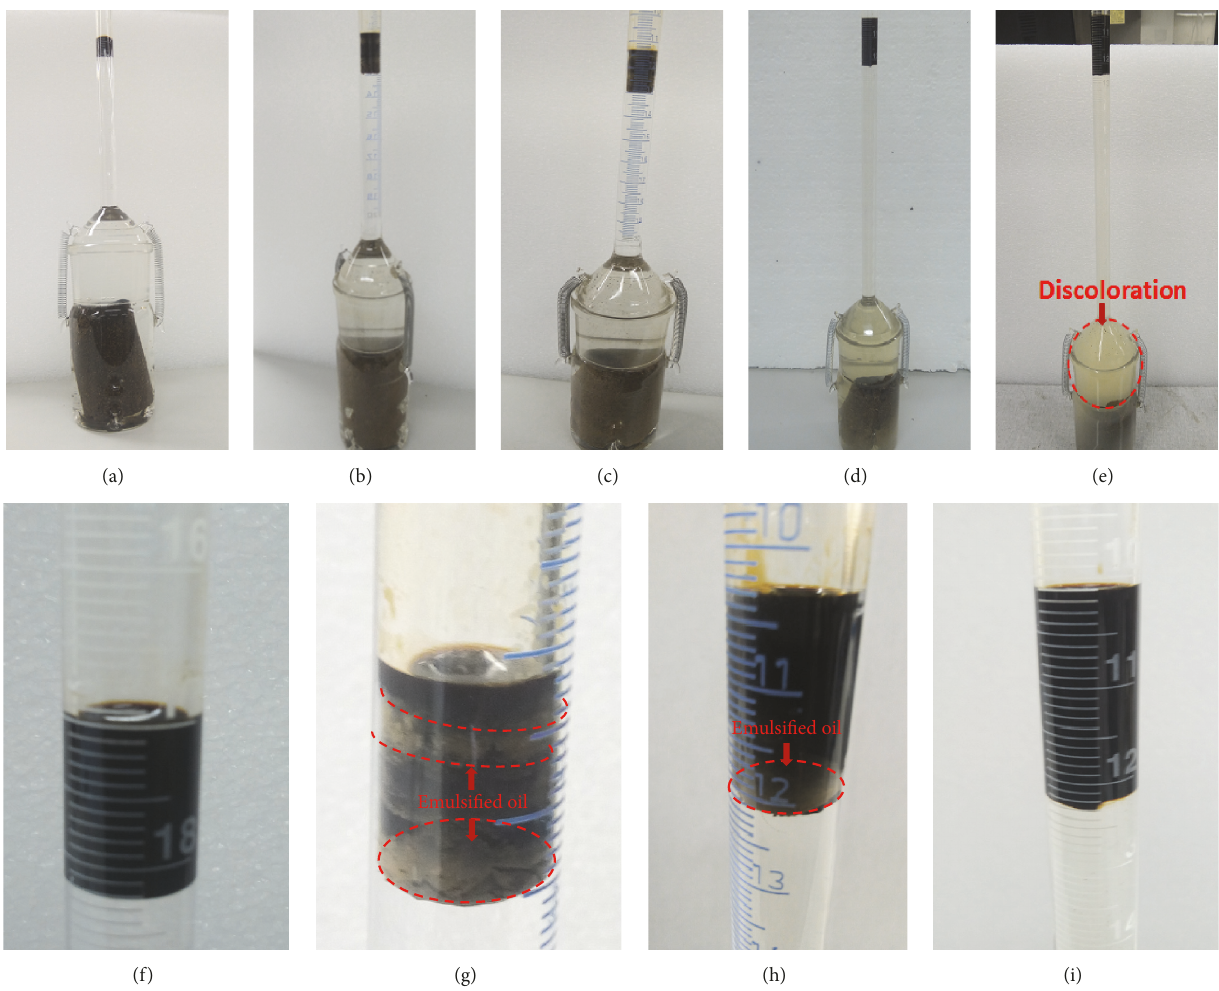
Figure 3: Spontaneous imbibition investigations: (a) core sample C23 in formation brine [FMB]; (b) core sample C24 in controlled salinity brine [CSB]; (c) core sample C25 in controlled salinity biosurfactant with greenzyme [CSBSB-G]; (d) core sample C28 in controlled salinity biosurfactant brine with rhamnolipids [CSBSB-R]; (e) observed changes in CSBSB-R system after about 25 days of imbibition; (f) sample of oil produced during FMB imbibition; (g) sample of oil produced during CSB imbibition; (h) sample of oil produced during CSBSB-G imbibition; (i) sample of oil produced during CSBSB-R